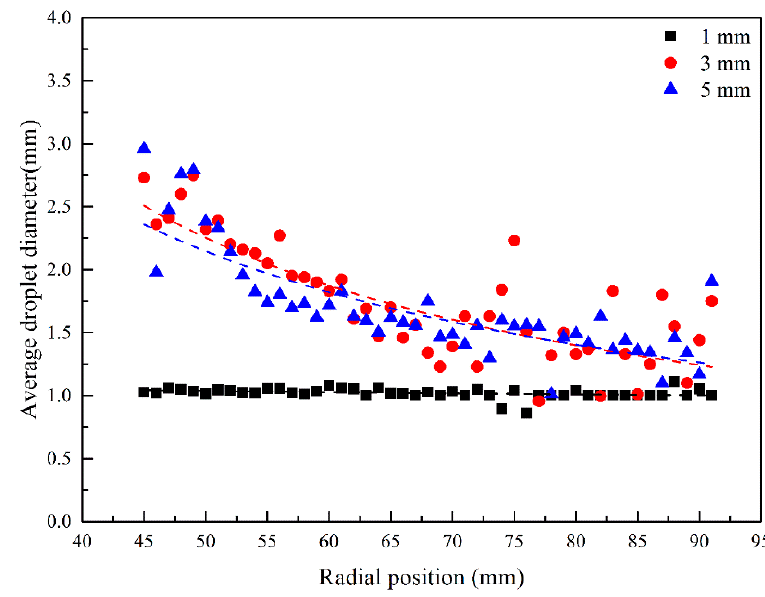
Figure 14. E ff ect of initial droplet diameter on average droplet Figure 14. Effect of initial droplet diameter on average droplet diameter.